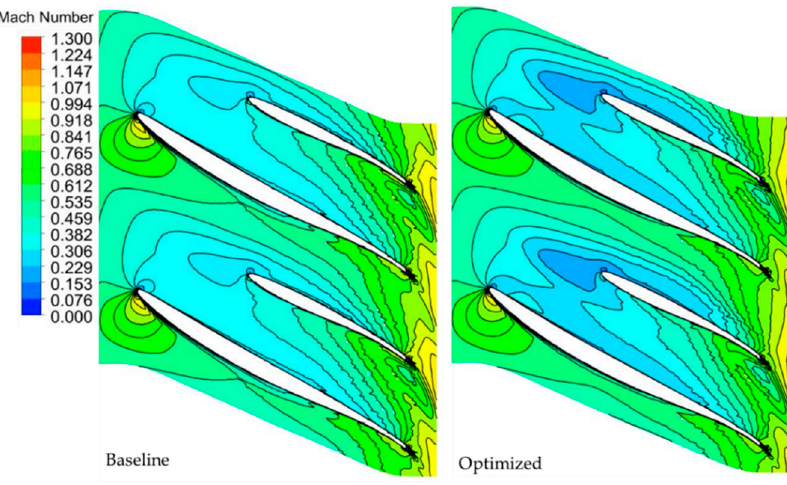
Figure 15. Mach number distribution for span 0.2 at the blade-to-blade contour.